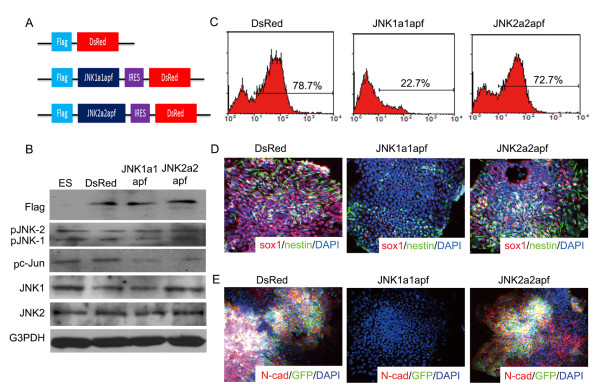
Genetic inhibition of JNKs in differentiating ES cells. (A) Flag-tagged dominant-negative mutants of JNK1 and JNK2 (JNK1a1-apf and JNK2a2-apf) were conjugated with IRES-DsRed for the tracing of the consistently expressing cells. (B) The expression of flag, phosphorylated JNKs, phosphorylated c-Jun (pc-Jun) and total amount of JNK1 and JNK2 were revealed by western blot. (C) Their efficiencies of neural formation were estimated by FACS analyses. The expressions of neural markers are also examined, such as Sox1 (D), nestin (D) and N-cadherin (N-cad) (E).